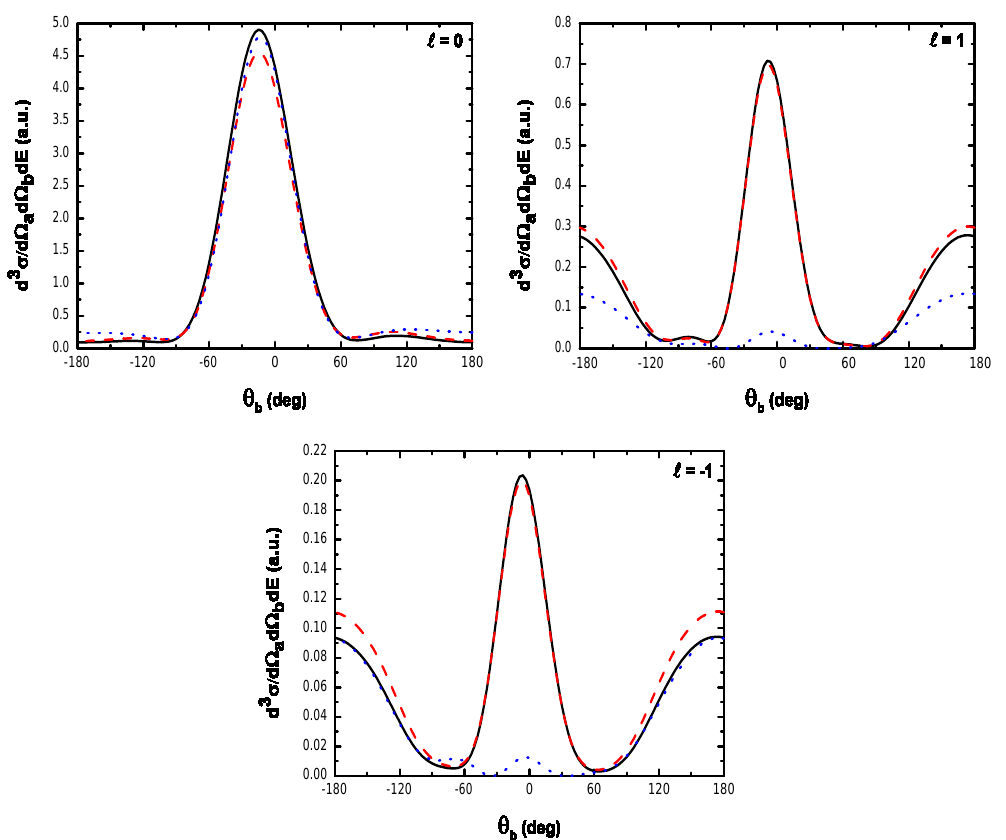
Figure 3. Triple differential cross sections corresponding to the laser-assisted electron-impact ionization process of atomic hydrogen as a function of the ejected angle θ b . The incident electron energy is = 40 eV, the ejected electron energy is E = 5 eV, and the scattering angle is θ a = 5 ◦ . The laser E k k b i frequency is ω = 1.17 eV and the electric field strength is est E 0 = 1 × 10 7 V/cm. The laser polarization vector of the field is set parallel to the wave vector of the incident electron ( ˆ ε // k i ) . : second Born approximation results. − − − : first Born approximation results. · · · · · : results obtained by ignoring the dressing of the